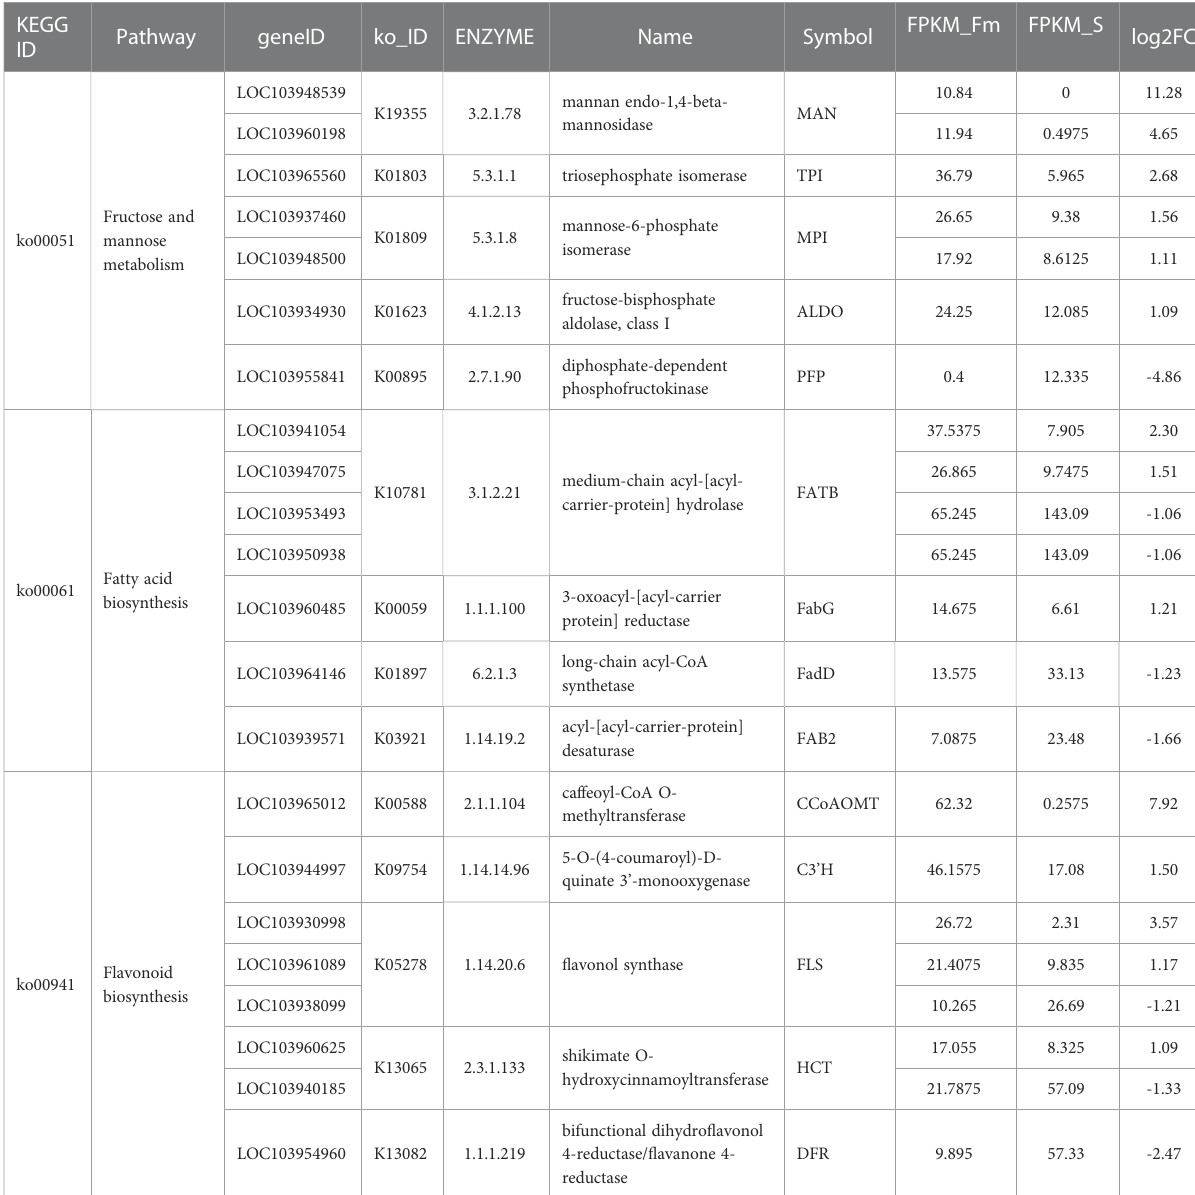
TABLE 5 KEGG enrichment analysis of fructose and mannose metabolism, fatty acid biosynthesis and fl avonoid biosynthesis pathway in Pyrus betulaefolia roots between Fm and S. KEGG ID